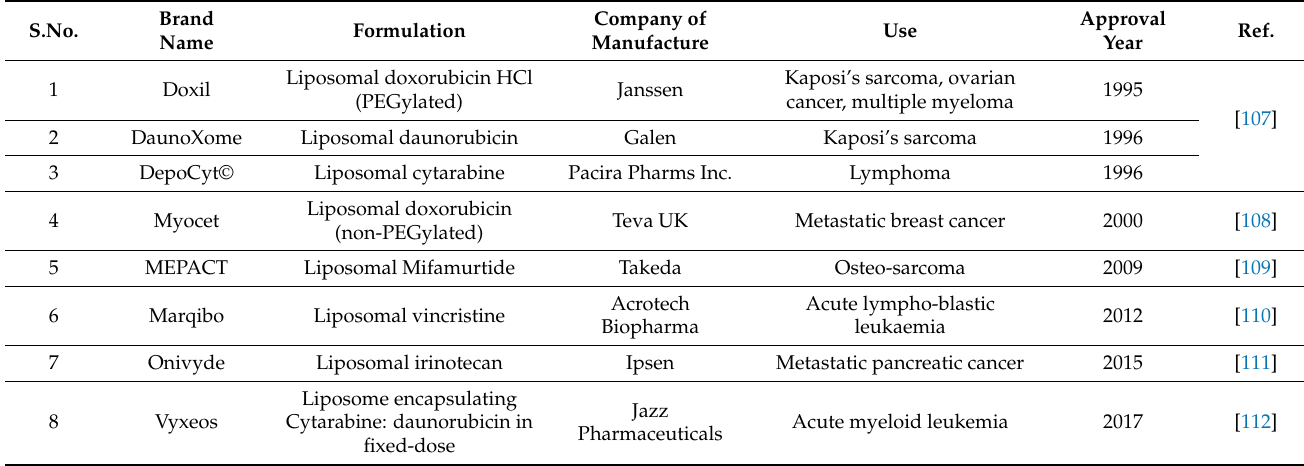
Table 4. FDA-approved LNPs for various diseases including